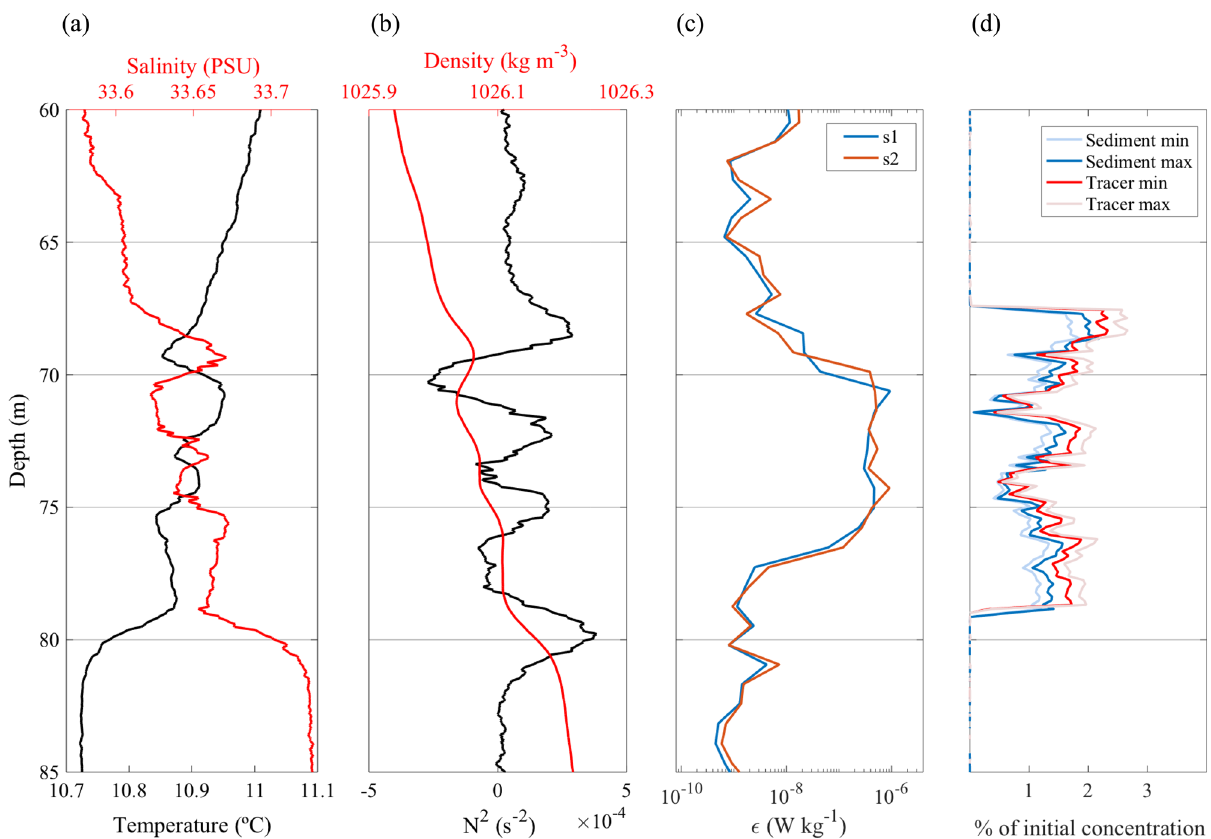
Fig. 3 Example of an epsilometer pro fi le measured during the discharge of the CCFZ sediment plume. The pro fi le was obtained 38 min after the start of the 45-min discharge. The water being sampled at this time would have been discharged into the ocean about 6 – 7 min earlier (i.e., the time it takes for a fl uid released from the discharge nozzle to descend to neutral buoyancy in the dynamic plume and be carried by ocean currents past the epsilometer). a Temperature and salinity data. b The density and buoyancy frequency ( N 2 ) derived from data in a ; the density pro fi le is signi fi cantly smoother than the temperature and salinity pro fi les as changes in the latter two result in smaller relative changes in density. c The turbulent kinetic energy dissipation rate ( ε ) detected by the two independent turbulence probes (s1 and s2). The inverse dilution factors (as a percentage of the initial concentration) of sediment and Rhodamine tracer are presented in d with error bounds indicated for each by the min and max signals associated with the corresponding sensor calibrations. An additional epsilometer pro fi le and a comment on the observations can be found in Supplementary Fig. 6 and Supplementary Notes 1,